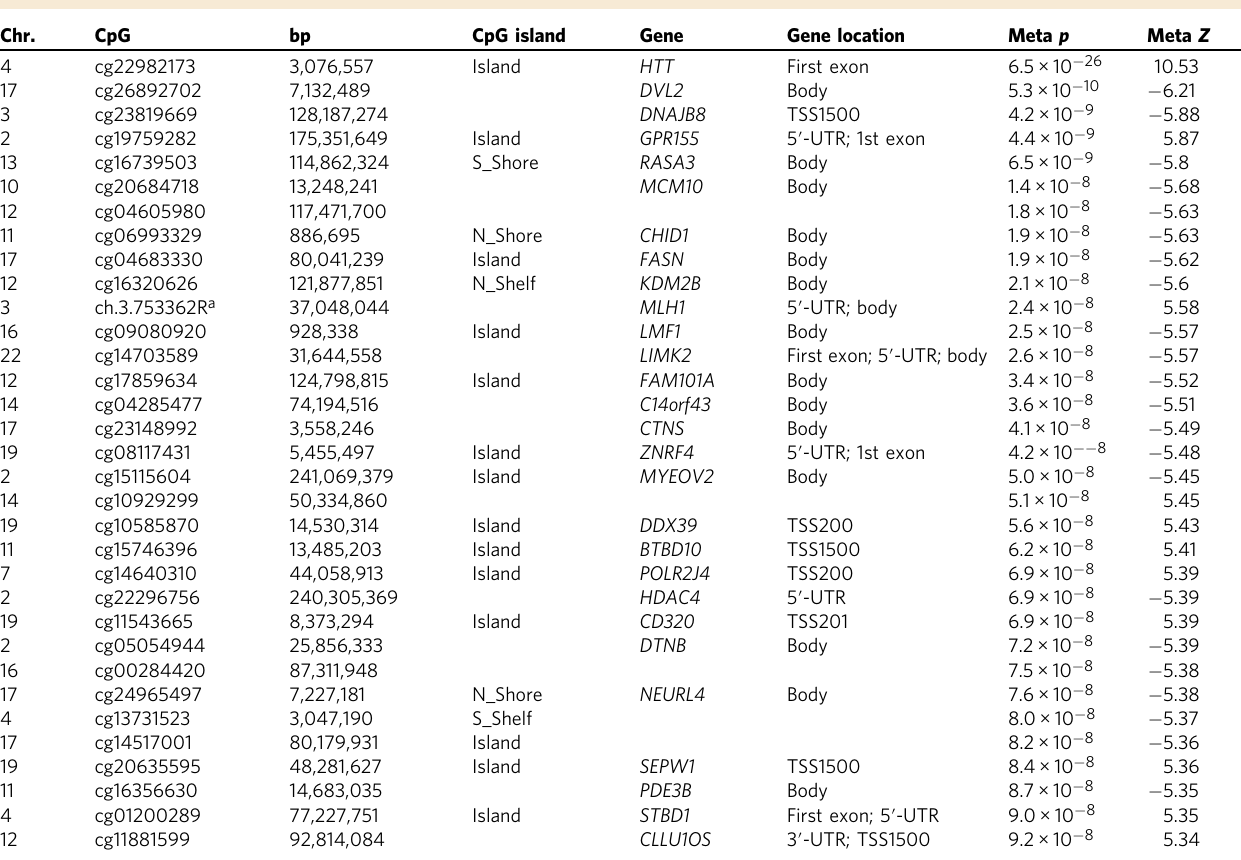
The table reports 33 genome-wide signi fi cant CpGs (meta-analysis p value <10 − 7 ). A positive (negative) value of the meta-analysis Z statistic indicates that the CpG is hypermethylated (hypomethylated)inhumanHDGECs.Inthiscase – controlstudy,wedidnotdistinguishpre-manifestfrommanifestHD.The Z statisticisbasedonStouffer ’ smeta-analysismethodacrosstheaggregated Enroll-HD samples and the Registry-HD data. Columns report the chromosome, CpG, position (hg19 assembly), the relative location to the nearest CpG island, nearest gene, location of the CpG with respect to the gene, meta-analysis (unadjusted, two-sided) p value, and Z